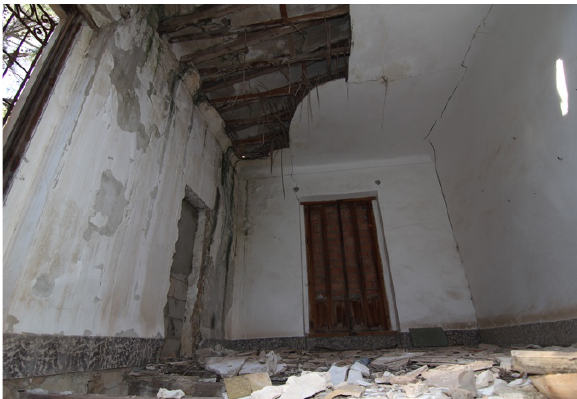
Figure 20. View of the new living room built in the twentieth century. The house was conceived as a free-standing cube-shaped building, with main and lateral façades carefully designed (Figure 21). The first is made up by a basement that occupied the entire height of the ground floor, topped by a cornice with two pilasters (one at each corner) that incorporated Attic bases, striated shafts and Tuscan capitals. There was a simplified entablature highlighting the pronounced cornice on the top of the façade. Its openings were organised: the main ones on a symmetry axis the second floor. Windows had lowered curved lintels bordered